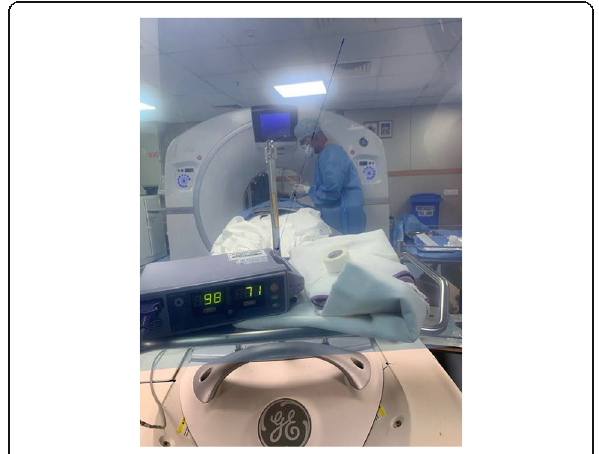
Fig. 3 A view through the transparent sheet. The operator is inserting the needle along the orbital angle of incidence guided by an assistant by seeing through the sheet